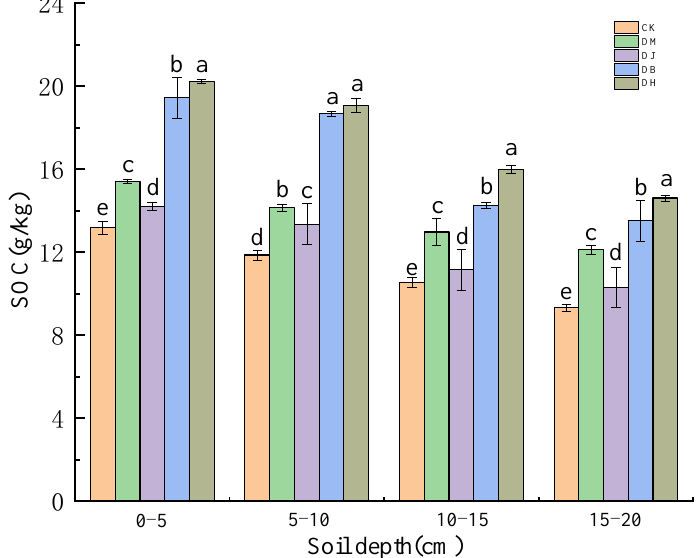
Figure 4. Distribution changes of soil organic carbon content in different treatments.